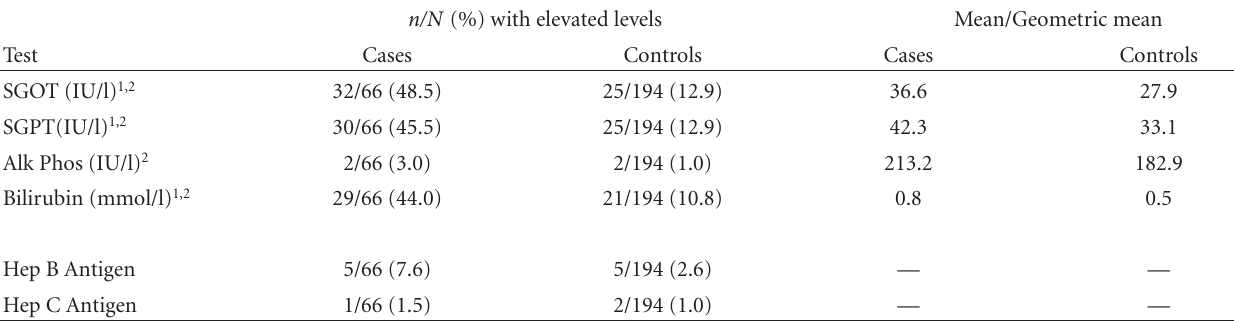
Table 3: Comparison of liver function between cases and controls, Gulran District, Afghanistan,